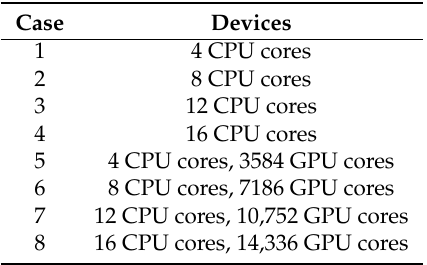
Figure 9. Target hardware for computing a proposed simulation framework. Table 2. Hardware